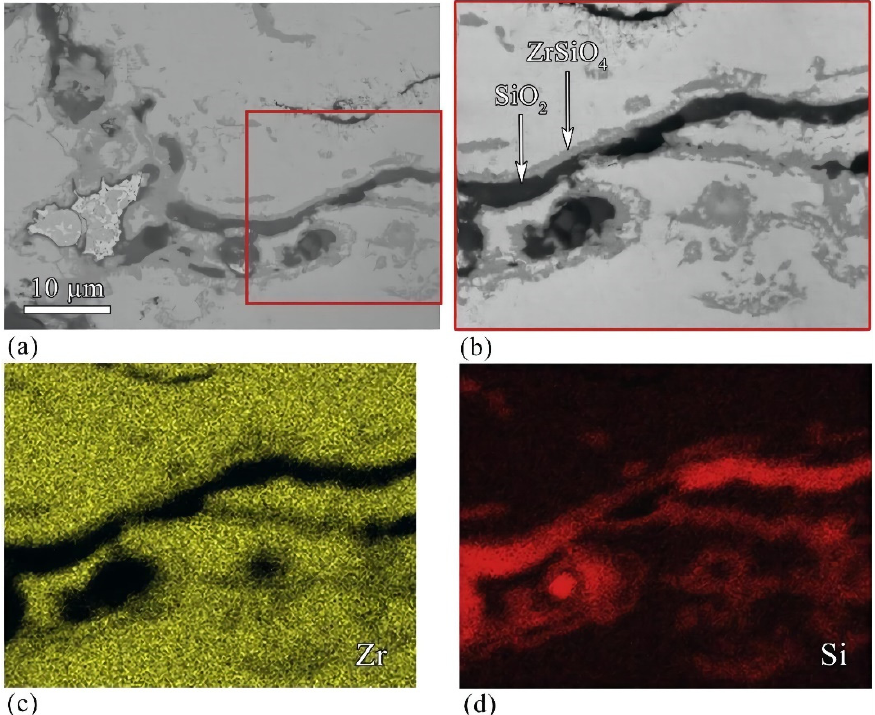
Figure 10. Healing of a crack in yttria-stabilized zirconia TBC with embedded MoSi 2; healing particles (HP) after exposure at 1100 °C for 20 h in air (cf. Figure 4). ( a ) Backscattered electron image of cross-section. ( b ) Enlargement of region indicated in Figure 5a. ( c ) Zr distribution and ( d ) Si distribution (X-ray maps), both corresponding with micro-graph Figure 5b [71].